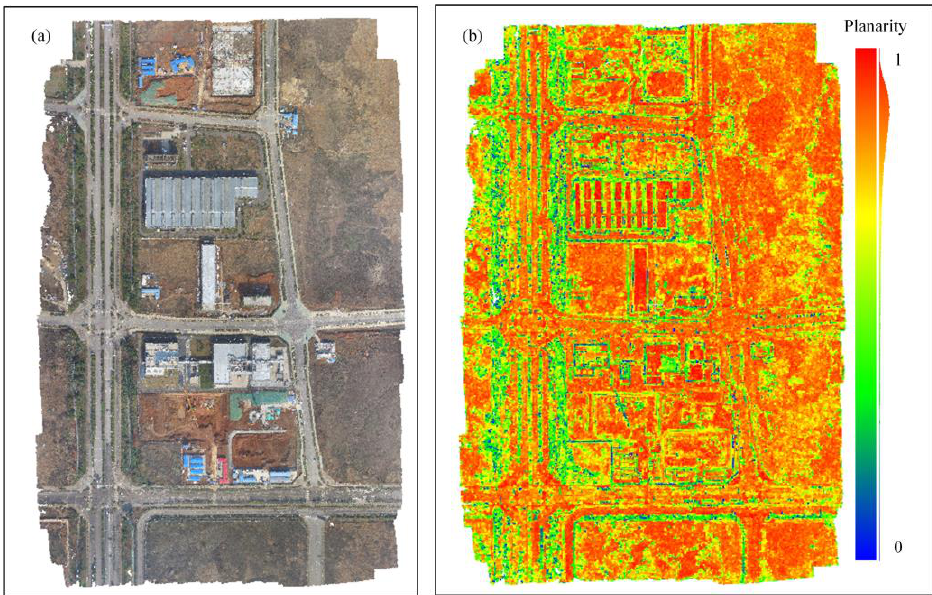
Fig.6 Planar voxel extraction from AT point clouds. (a) AT point clouds of the calibration field rendered by image color. (b) AT point clouds rendered by planarity for each voxel.